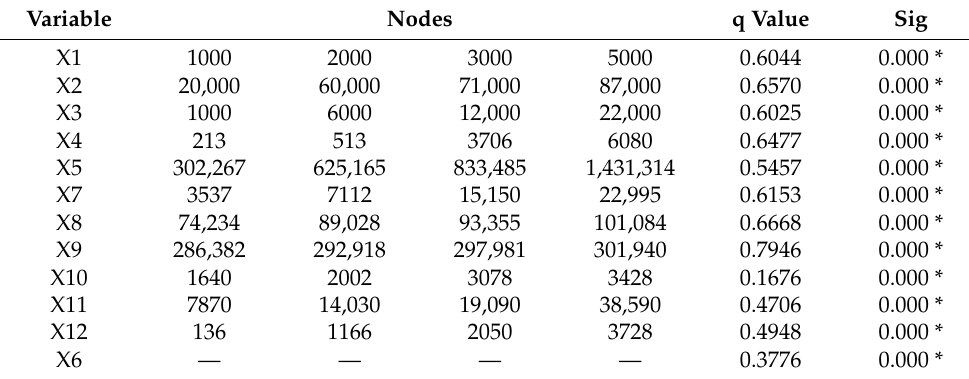
Table 3. Nodes, q-values, and significance of the independent variable X.